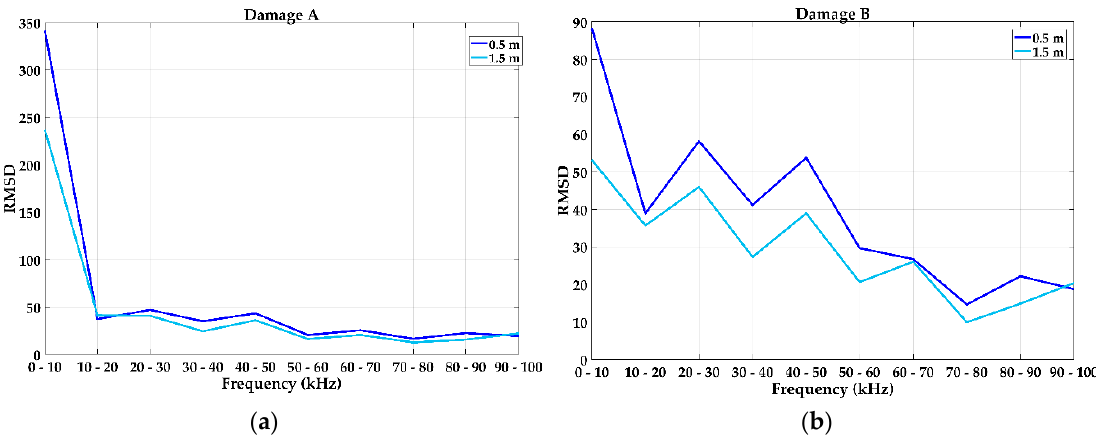
Figure 5. RMSD for damages A ( a ) and B ( b ) in two different